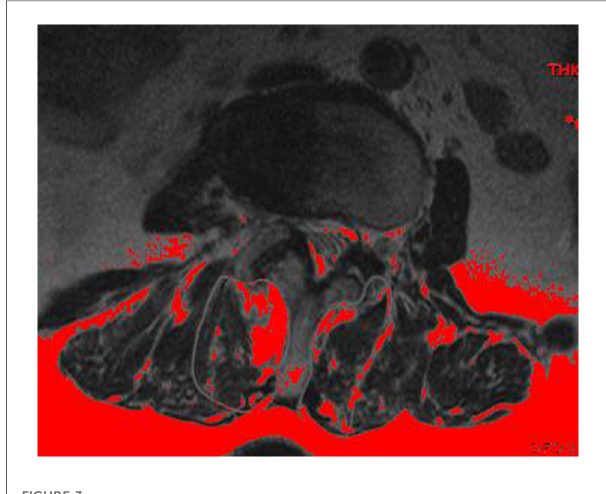
FIGURE 3 Fat tissue on the MRI is colored in red (a darker background in the red version) using the threshold technique.